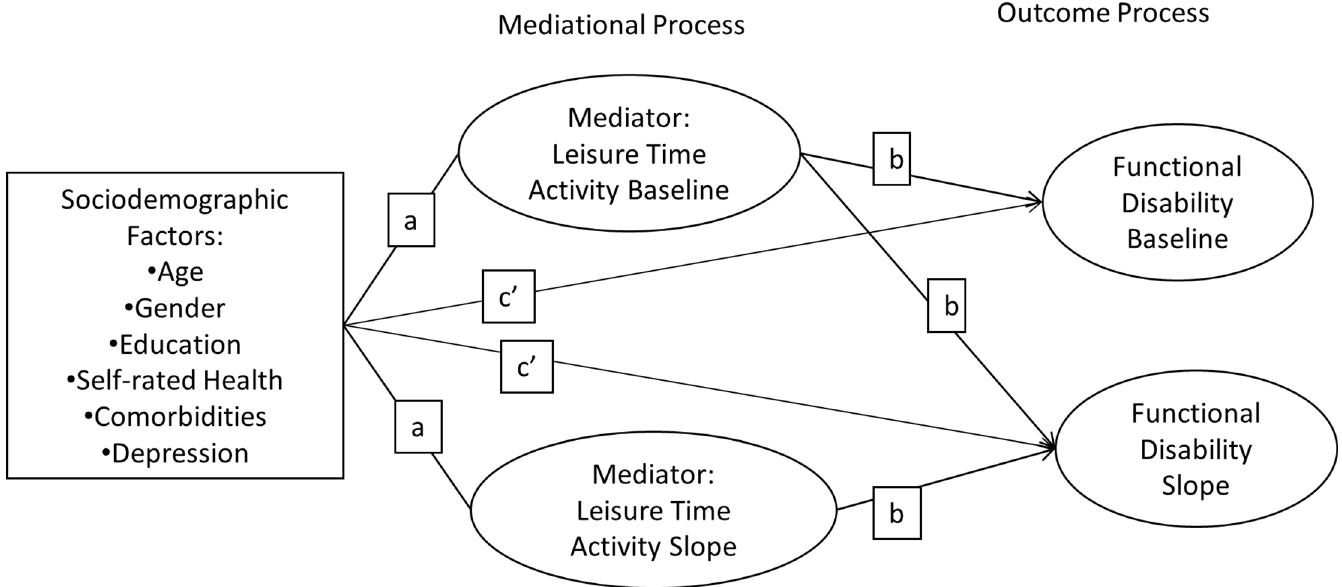
Fig 1. Mediation model with leisure time activity as mediator between six predisposing factors and functional disability.